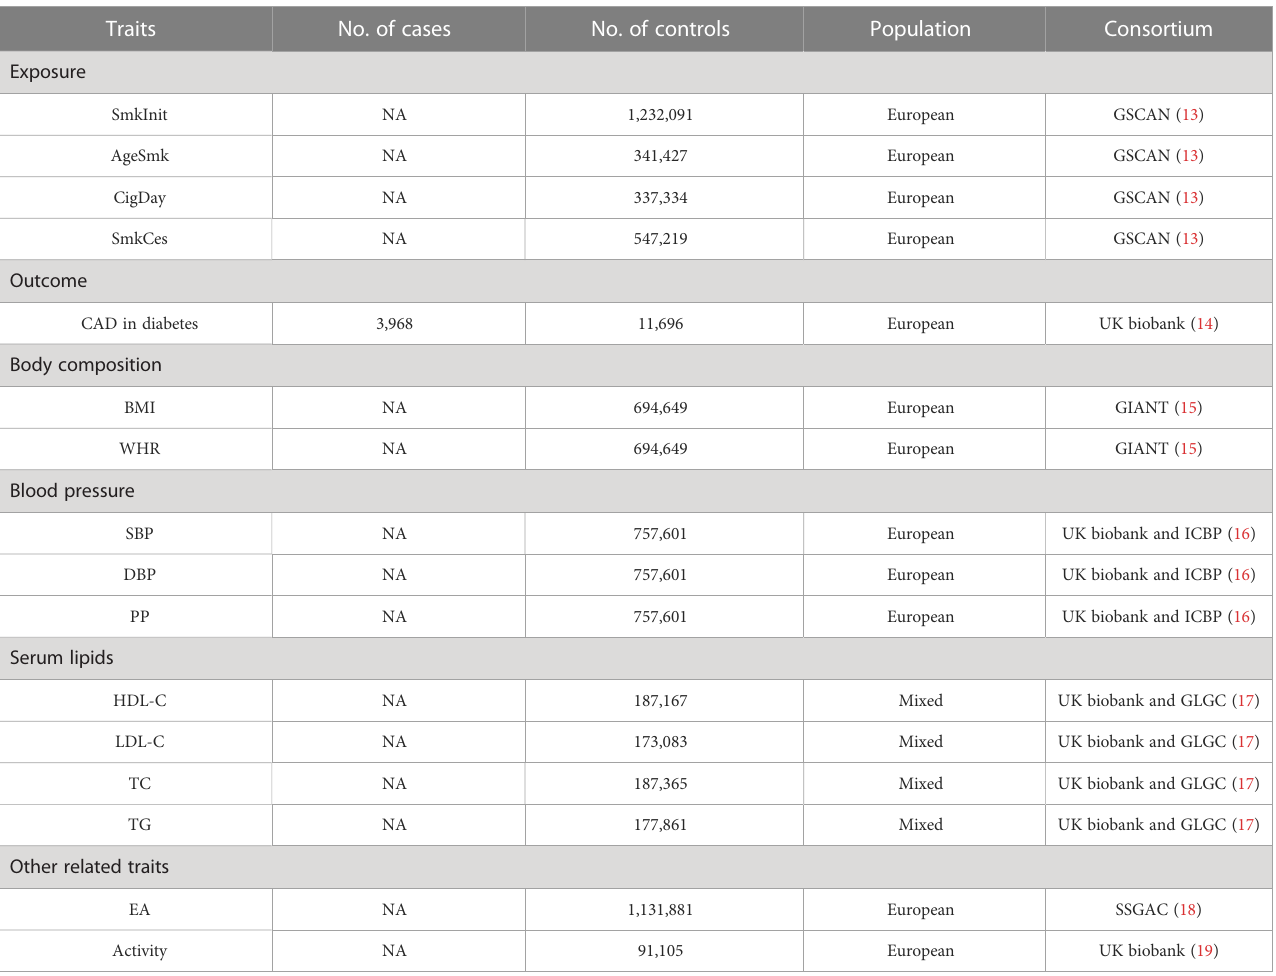
TABLE 1 Overview of data sources.